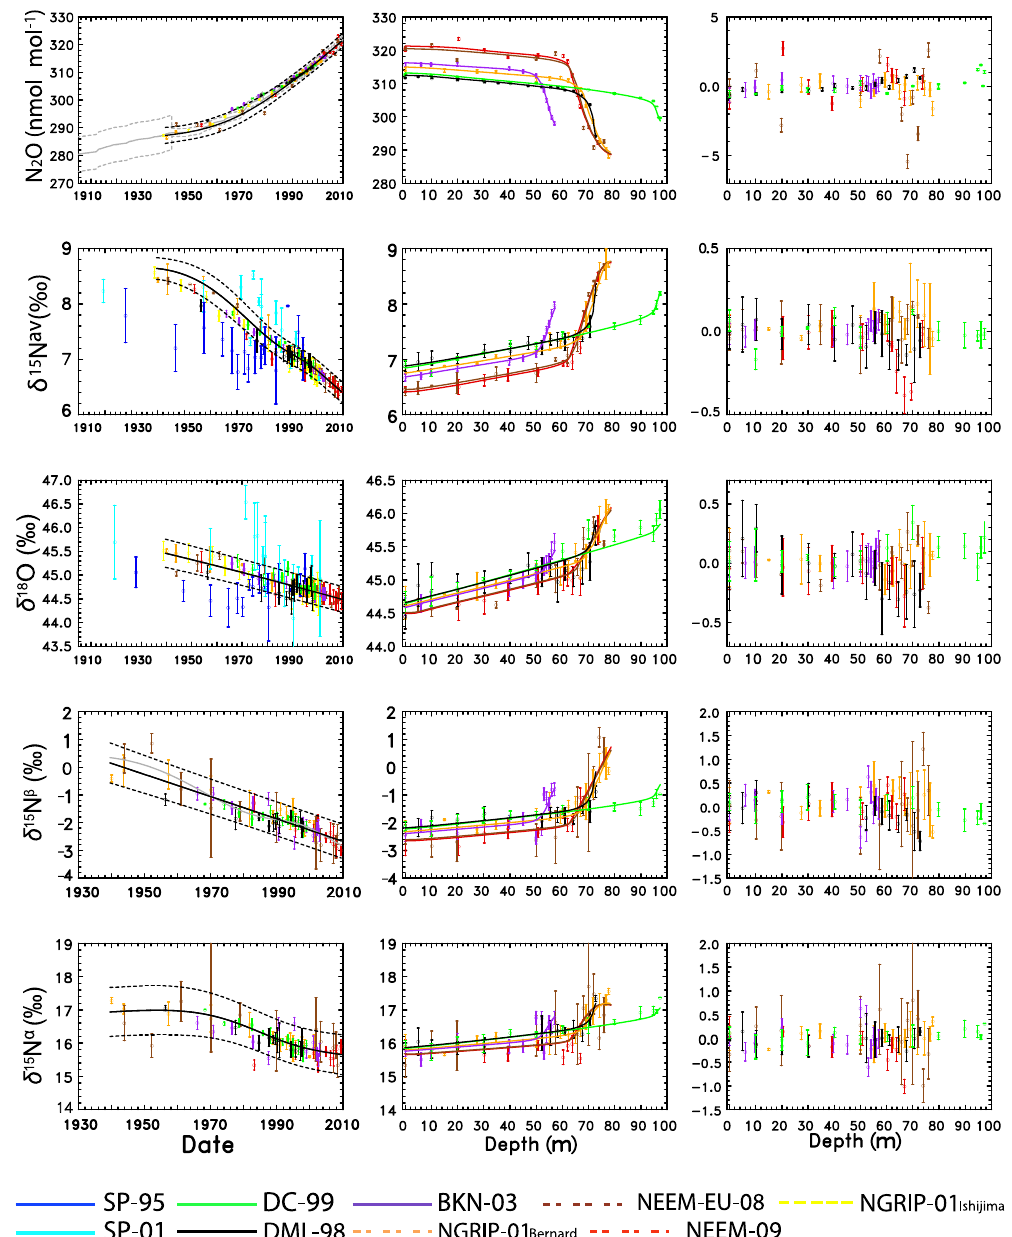
Figure 2. Left: reconstructed atmospheric scenarios (black solid line with dashed lines indicating the 2 σ uncertainty intervals) and results of the firn air samples (corrected for firn fractionation) plotted at their respective assigned mean age. Middle: corresponding depth profiles; symbols show the measurements and solid lines the results of the forward model using the best estimate scenario as input. Right: model data discrepancies as a function of depth. Orange: NGRIP-01 Bernard ; yellow: NGRIP-01 Ishijima ; brown: NEEM-EU-08; red: NEEM-09; purple: BKN-03; black: DML-98; green: DC-99; blue: SP-95; and light blue: SP-01. Data from NGRIP-01 Ishijima SP-95 and SP-01 were not used in the atmospheric reconstruction and are only plotted for comparison purposes